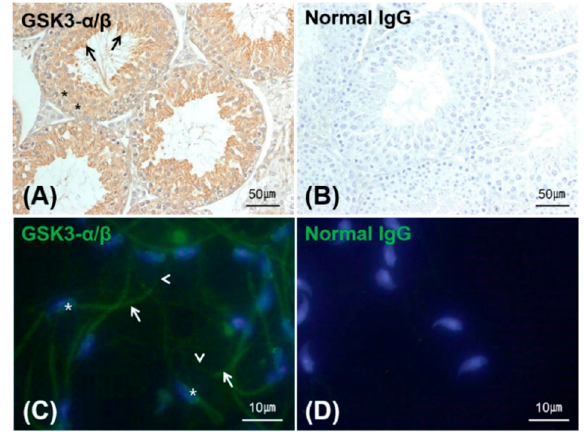
Figure 3. Representative images of of GSK3 α / β immunohistochemistry staining in mouse testis ( A , B ) and epididymal sperm ( C , D ). Anti-GSK3 α / β antibody was used for visualizing the localization of GSK3 α / β ( A (Brown), C (Green)), whereas normal IgG was used as a negative control ( B , D ). Brightfield ( A , B ) and fluorescence images ( C , D ) were obtained from simulated HRP-conjugated secondary antibody/DAB and Alexa488-conjuaged secondary antibody, respectively. In the testis, GSK3 was expressed in the Sertoli cells (asterisks) and developing germ cells including sperm (arrows); in epididymal sperm GSK3 (green) was expressed in the head (asterisks), midpiece (arrows), and principal piece of the tail (arrowheads). Nuclei were stained blue by DAPI.